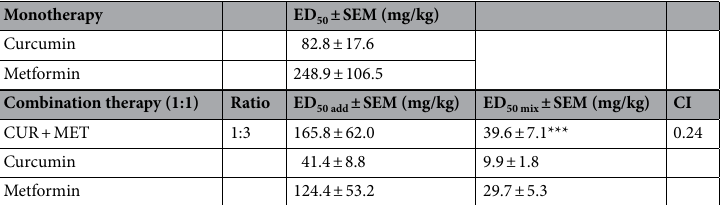
Table 1. 50% antinociceptive doses and interaction index of curcumin, metformin, and curcumin–metformin combination in phase II of mouse formalin test. The ED 50 values were determined from linear regression analysis of the log dose–response curves. The theoretical ED 50 (ED 50 add ) was calculated based on the dose–response curves of the curcumin and metformin monotherapy. The experimental ED 50 (ED 50 mix ) was determined by the experimentally derived dose–response curve of the curcumin–metformin combination treatment. The ED 50 s are presented with their respective S.E.M. values. CI combination index. *** p < 0.001 compared to the ED 50 add (student’s t-